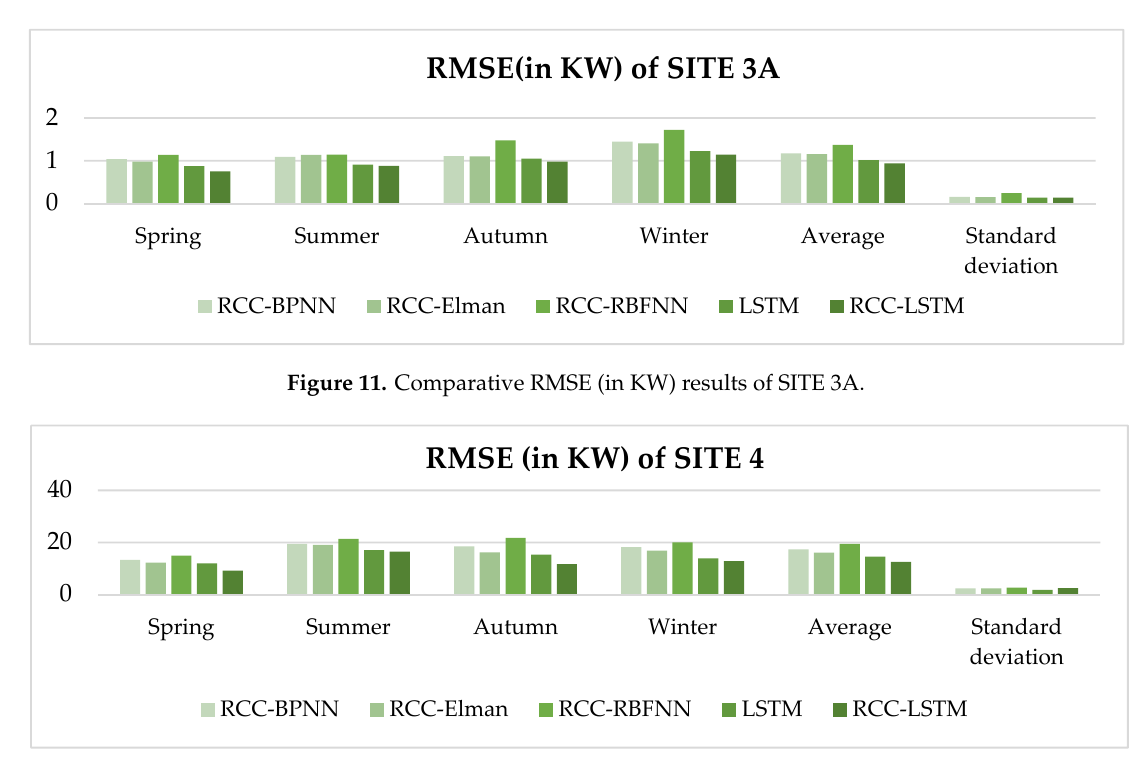
Figure 12. Comparative RMSE (in KW) results of SITE 4.